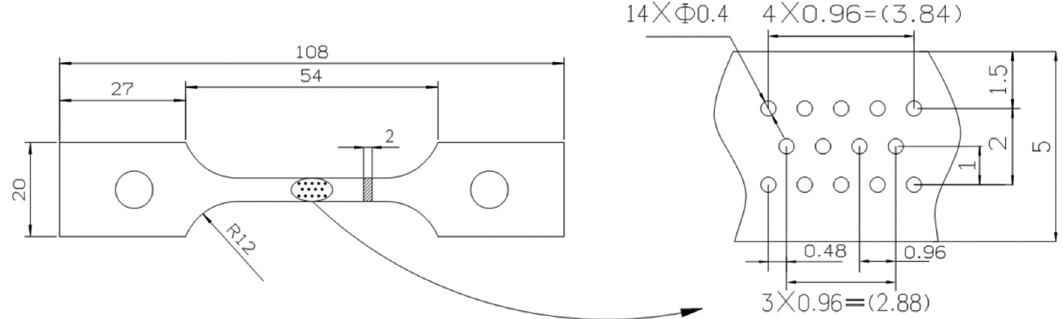
Figure 1: Specimen with 14 fi lm cooling